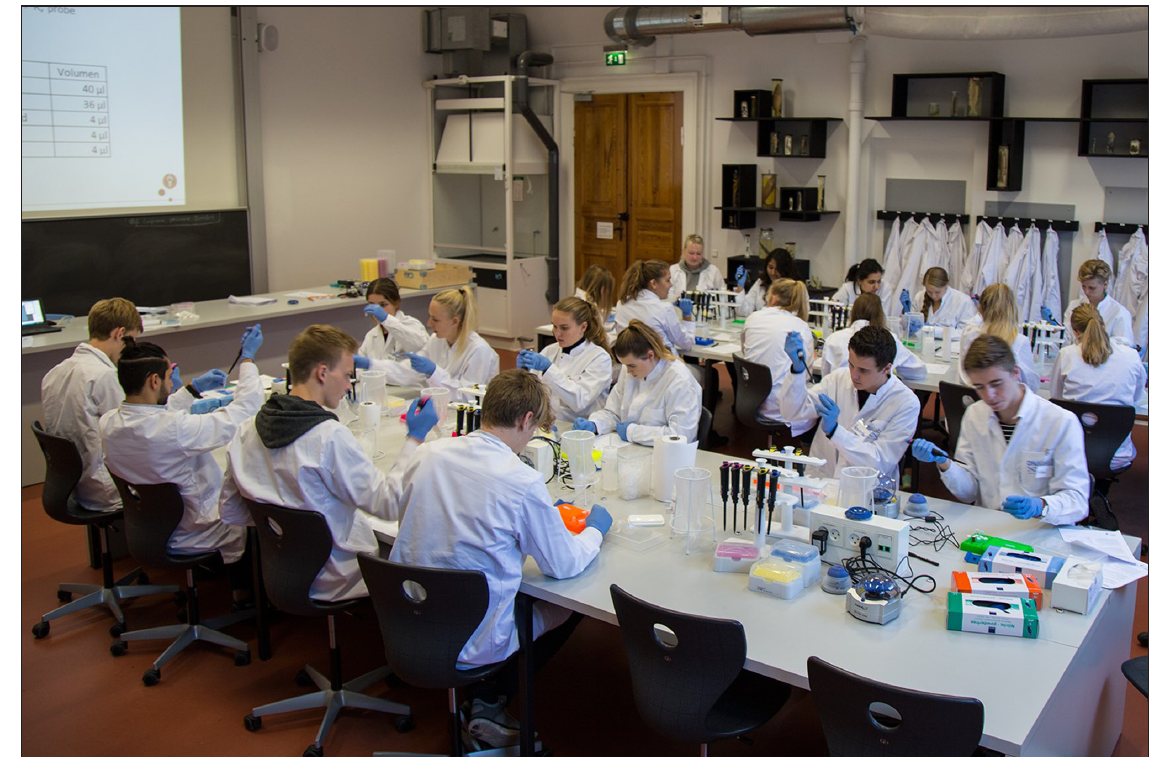
Figure 3 Citizens at work in the DNA laboratory, working with eDNA samples and analyses, October 2015. Photo by Anders P.